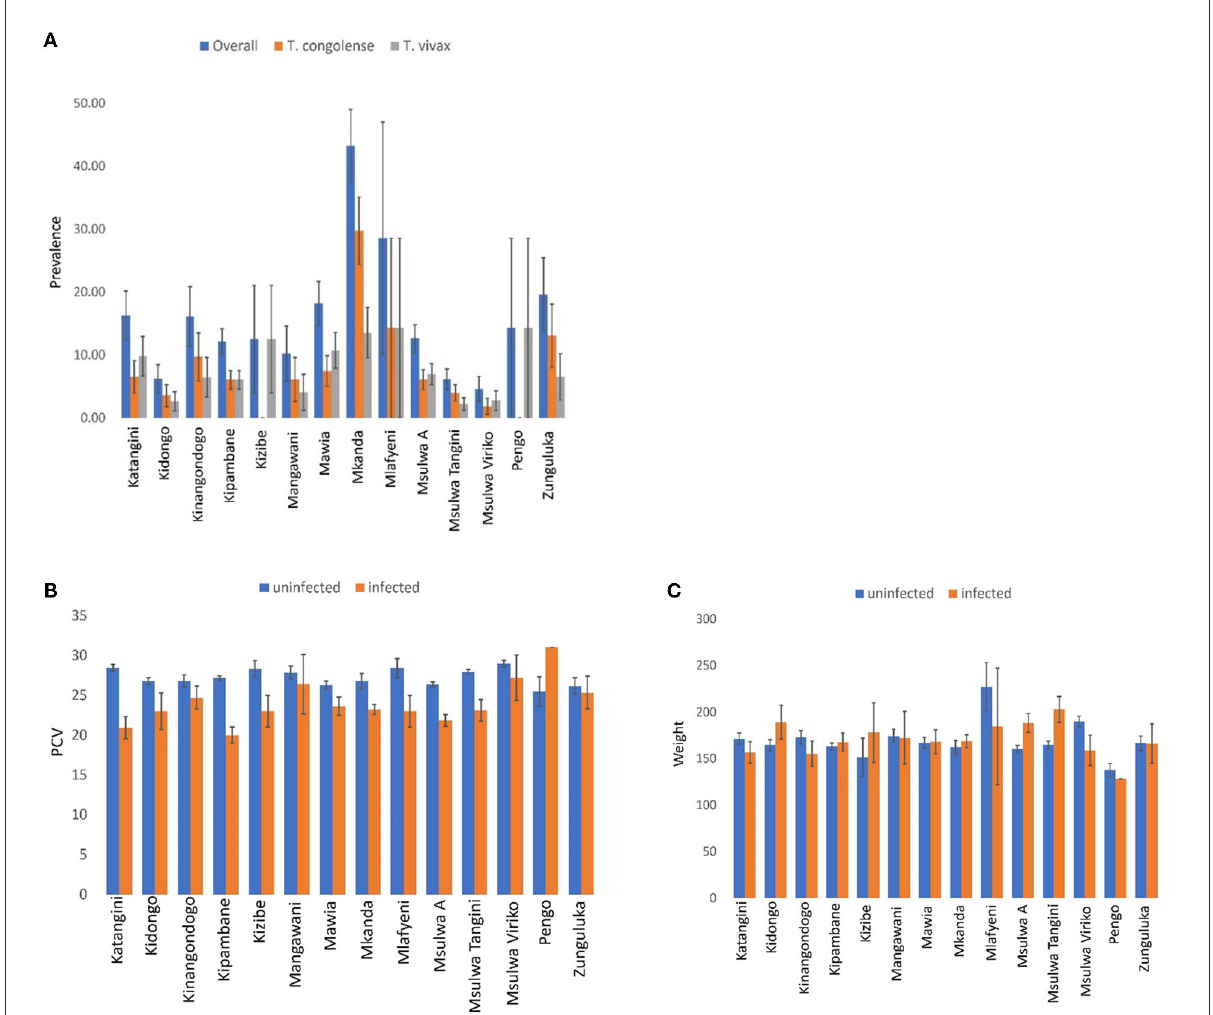
FIGURE10 Bar-charts showing: (A) Trypanosome infection prevalence, (B) packed cell volume (PCV), and (C) girth measurements in cattle populations in Shimba Hills. Error bars are used to indicate the standard error of the mean (SEM).